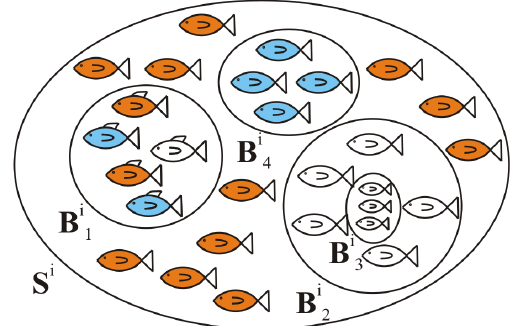
Figure 2. A set of individuals belonging to species S i can be di- vided into subsets B i . All individuals belonging to a certain subset j B i belong to the same j